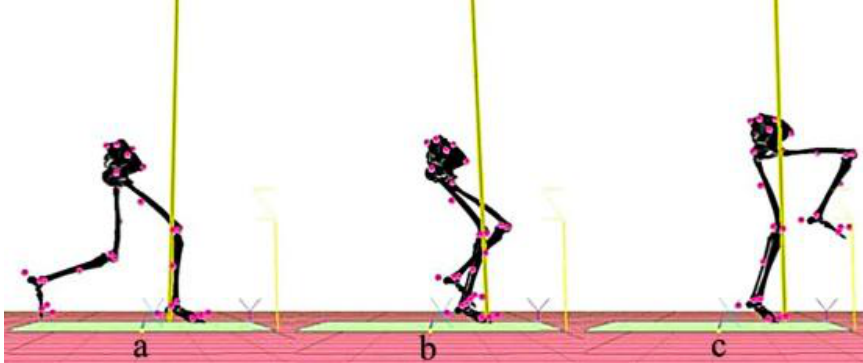
Figure 1. ( a ) Touchdown, ( b ) downward, and ( c ) push-off phases in typical layup jumps (LJs). The yellow lines denote the resultant ground reaction forces. yellow lines denote the resultant ground reaction